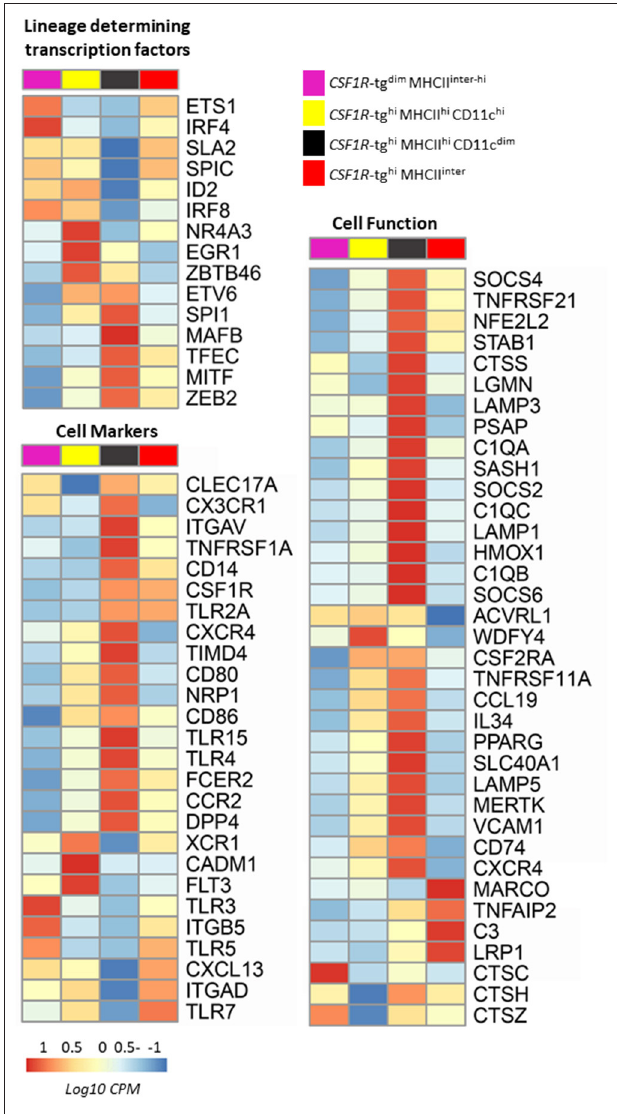
FIGURE 9 | The CSF1R -tg hi MHCII hi and CSF1R -tg hi MHCII inter cells are enriched with transcripts related to cDC, macrophage and red pulp macrophage function. FACS sorted CSF1R -tg + subpopulations were analyzed by RNA-seq for lineage-specific transcription factors and genes related to function. The CSF1R -tg hi MHCII hi CD11c hi subpopulation was enriched for cDC transcription factors ( EGR1, IRF8, ID2, NR4A3 , and ZBTB46 ) and the CSF1R -tg hi MHCII hi CD11c dim subpopulation was enriched for macrophage signature genes ( MAFB, MITF, SPI1, TFEC, ZEB2 ). The CSF1R -tg dim and CSF1R -tg hi MHCII inter subpopulations were enriched for transcripts associated with red pulp macrophages ( SpiC ) and regulation of CSF1R expression ( ETS1, SLA2 ). The CSF1R -tg hi MHCII hi CD11c hi cells were enriched with cells expressing gene related to the cDC lineage ( CADM1, FLT3, XCR1 ) and CSF1R-tg hi MHCII hi CD11c dim subpopulation were enriched macrophage related genes ( CCR2, CD14, CX3CR1, CXCR4, TNFSF1A ). The CSF1R -tg hi MHCII inter subpopulation was enriched for cells expressing red pulp macrophage-related genes ( C3, LRG1 , and MARCO ). The CSF1R -tg dim subpopulation were enrich with a mixture of different cell lineages expressing genes related to the cDC and macrophage lineages. Heatmaps of log10 transformed normalized expression of genes. Heatmaps coloring is based on counts per million with red indicating high counts and blue indicating low